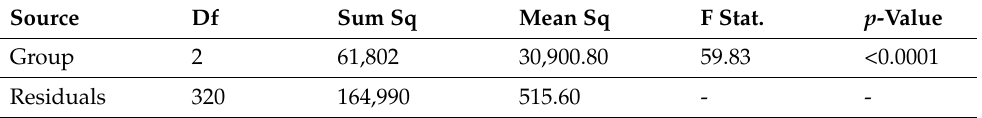
Table 6. Post hoc analysis with Benjamini–Yekutieli procedure for LVEDVi in patients with HF and AF. Contrast Adjusted p -Value HFrEF vs. HFmrEF <0.0001 HFrEF vs. HFpEF <0.0001 HFmrEF vs. HFpEF